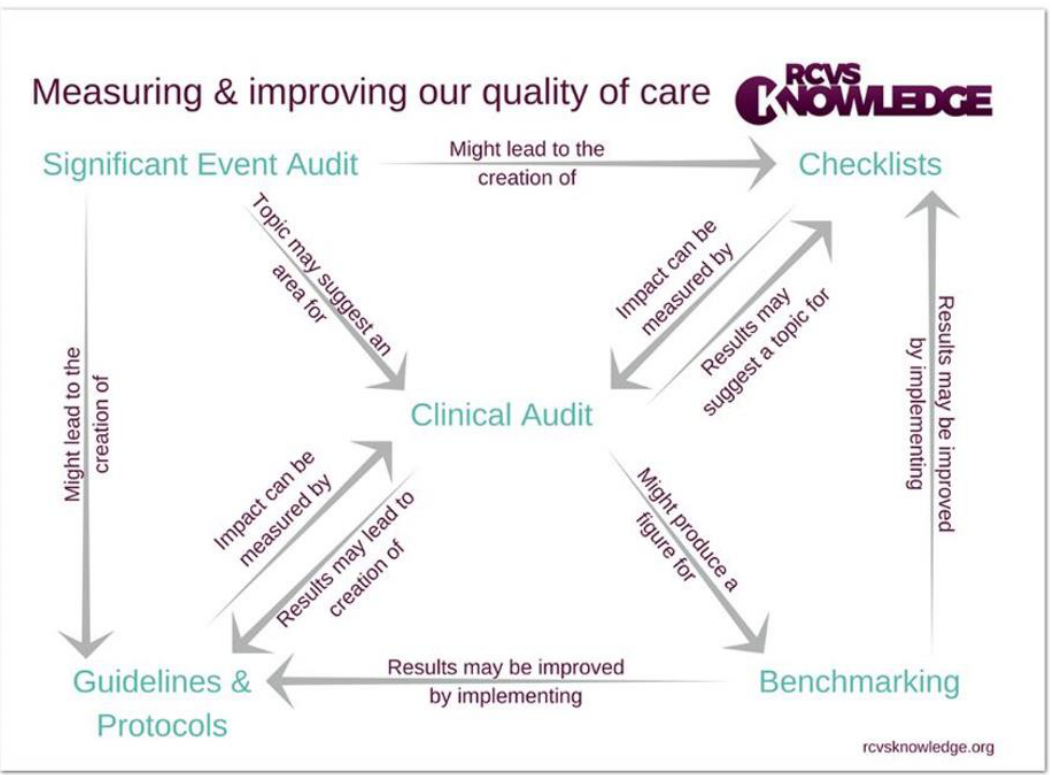
Figure 1: The relationships between audits and processes of quality improvement (RCVS